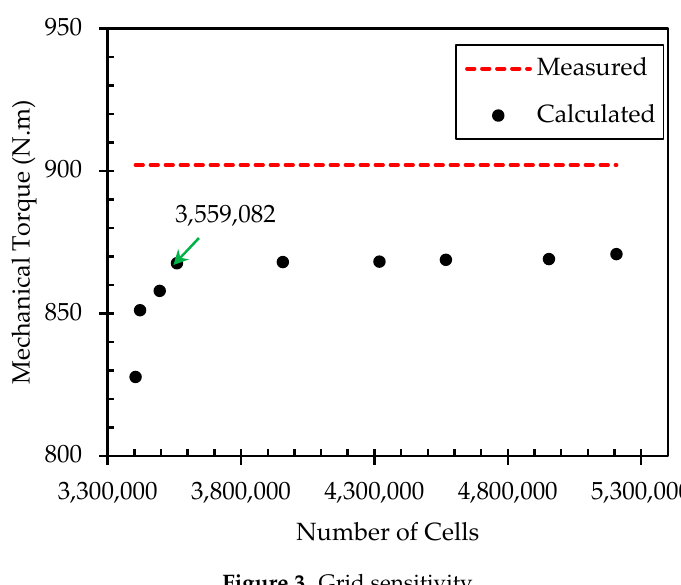
Figure 3. Grid Figure 3. Grid sensitivity .